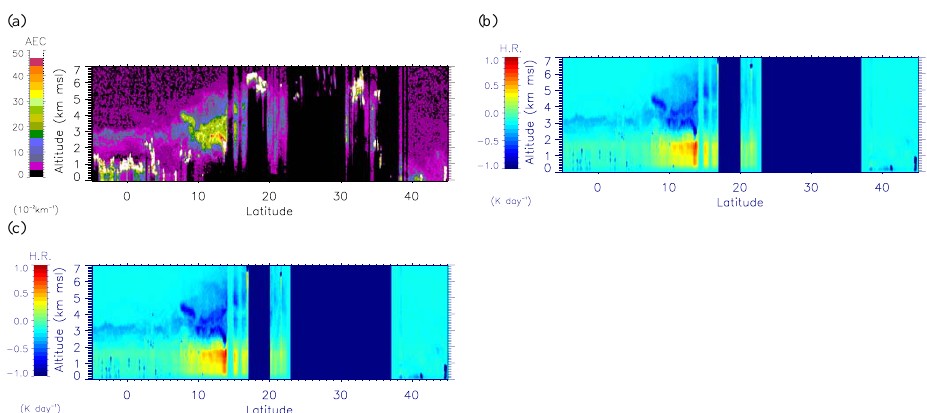
Fig. 16. Aerosol Extinction coefficient profiles derived from the CALIOP lidar on 13 June at 01:39 UTC (a) . Heating rate derived using the RaCH model (b) and the CHOM model (c)